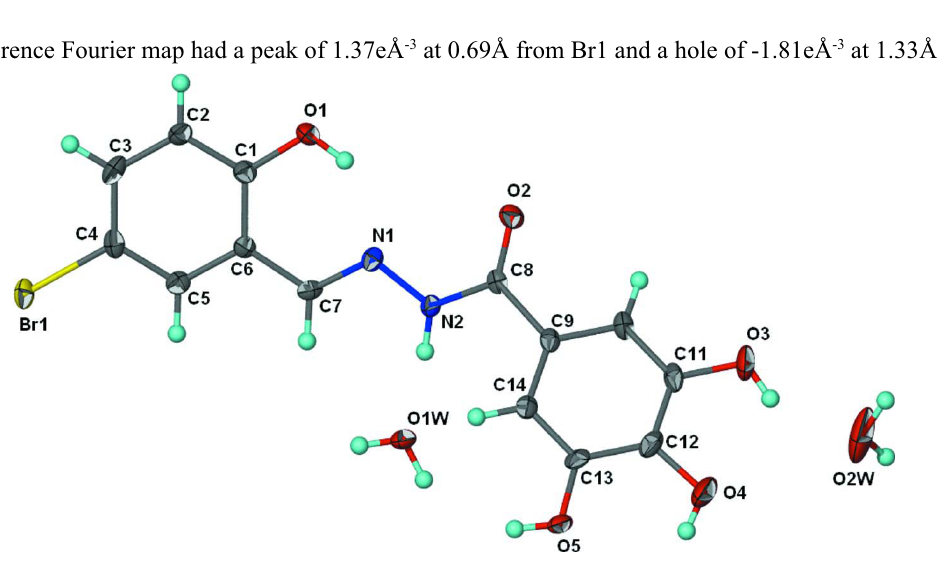
Figure 1 View (Barbour, 2001) of N -(5-bromo-2-hydroxybenzylidene)-3,4,5-trihydroxybenzohydrazide with displacement ellipsoids at the 70% probability level. Hydrogen atoms are drawn as spheres of arbitrary